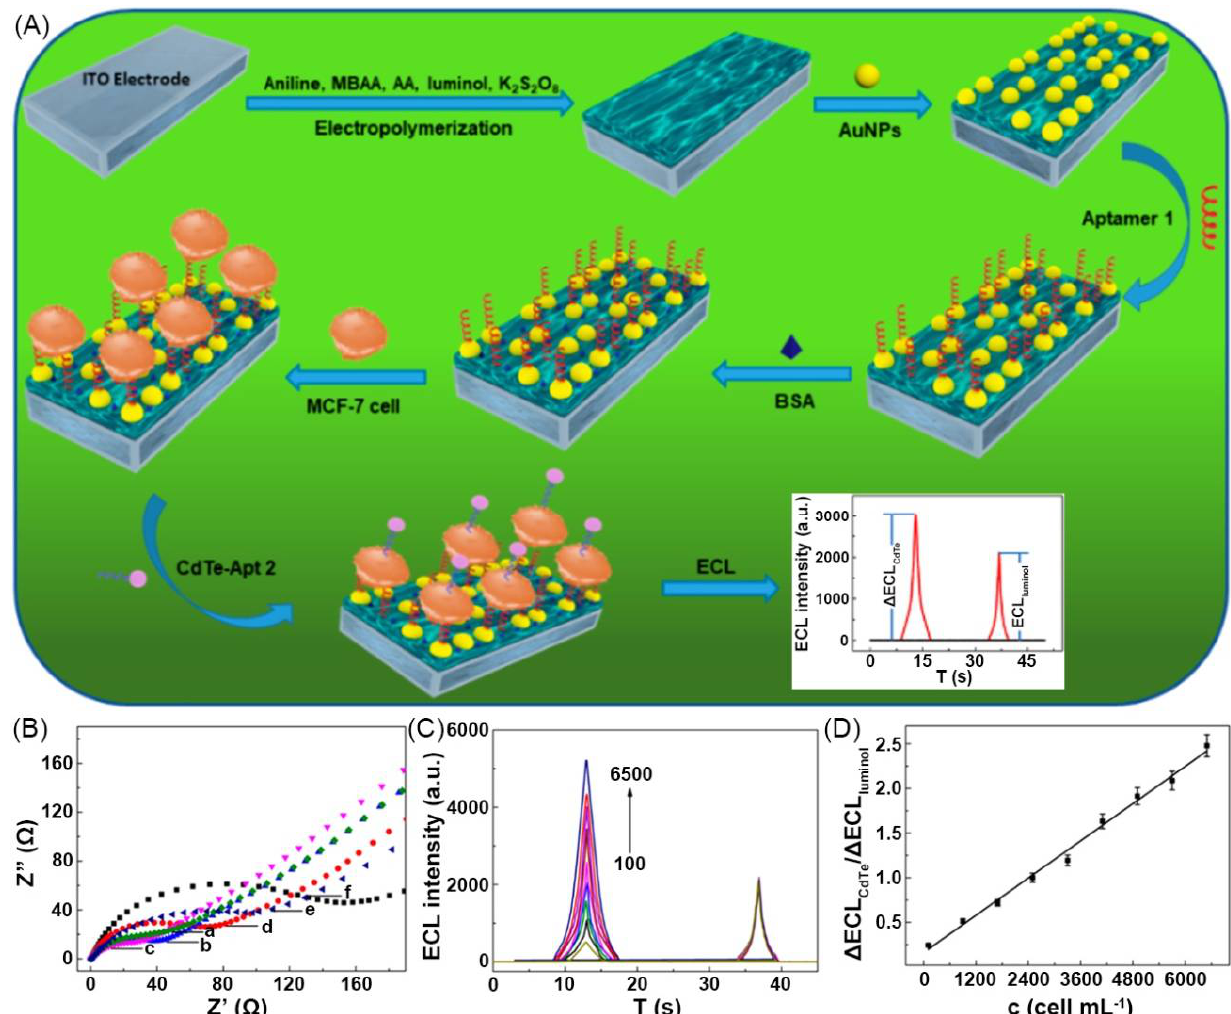
Figure 6. ( A ) Schematic of ratiometric ECL cytosensor working principle. ( B ) EIS characterization of sensing interfaces in 0.1 PBS (pH 7.4) with 0.1 KCl and 5.0 mM [Fe(CN) 6 ] 3–/4– . ( C ) Time dependence of ECL intensity of CdTe nanoprobes with different MCF-7 cell concentrations (100–6500 cells·mL −1 ). ( D ) Calibration ΔECL CdTe /ΔECL luminol −cell concentration curve. Adapted with permission [96]; copyright 2019, American Chemical Society.